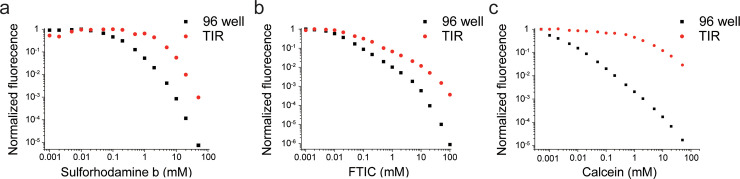
Normalized fluorescence signal per fluorophore at different concentrations recorded with conventional fluorometer and TIR microscope.Fluorescence signals from the conventional fluorometer are significantly underestimated by approximately two to three orders of magnitude (black dots). In TIR, 1000-fold self-quenching is observed at 50 mM sulforhodamine B solution (a) and 100 mM fluorescein isothiocyanate (FITC) solution (b). Calcein shows only 100-fold quenching at 50 mM concentration (c). Raw data can be found in S1 Table in S1 File.